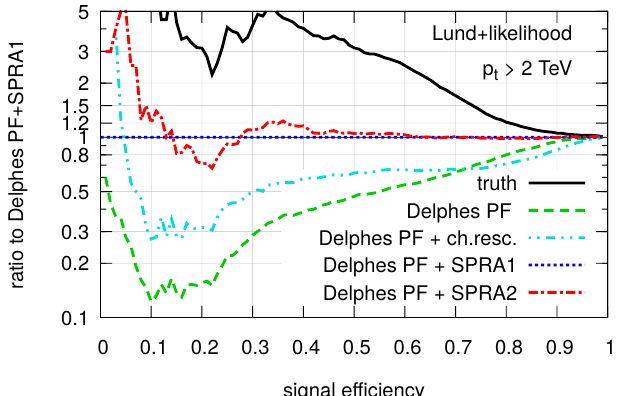
Figure 20. Performance of the Lund-likelihood discriminator, at truth level and with Delphes PF, with and without the SPRA algorithms, and also with charge rescaling. As a function of signal e(cid:14)ciency, the plot shows the ratio of background rejection relative to that obtained for Delphes PF+SPRA1. The log-likelihood maps have been determined separately for each setup (truth, Delphes PF, etc.). The generation and selection of jets is as described in section 3.4, using the dijet process, selecting jets with the requirement p t > 2 TeV, j y j < 2 :